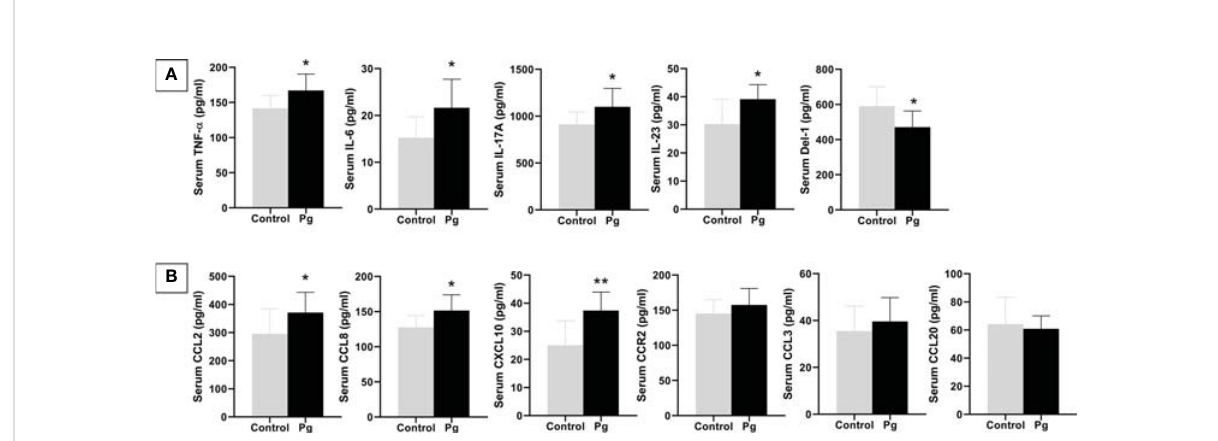
FIGURE 6 Effects of the oral administration of Porphyromonas gingivalis on serum in fl ammatory cytokines (A) and chemokines (B) between mice in the P. gingivalis -administered group and the control group determined by ELISA. * p < 0.05, ** p < 0.01. N = 6. Data are expressed as the mean ± SEM.